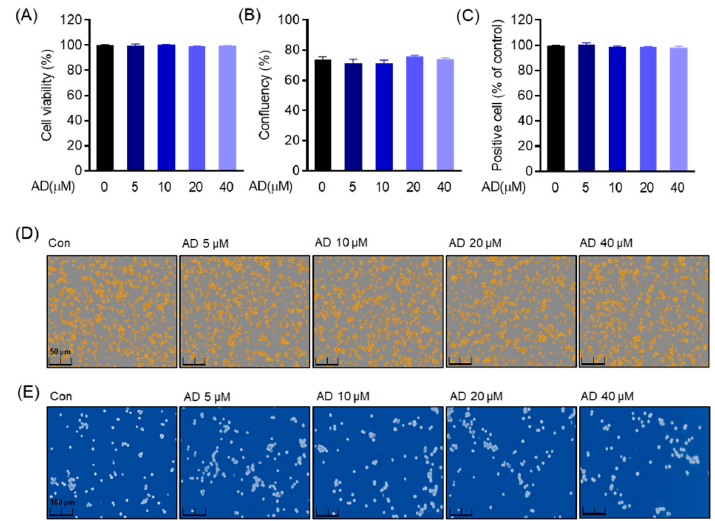
Figure 2. Cell viability and confluency. Cytotoxic effect of AD at the indicated concentration after treating for 5 days at the density of 1 × 10 3 cells/well in the 96-well plate. ( A ) Measurement of cell viability by MTT. ( B , D ) Cell confluency measurement by Incucyte ® Live Cell analysis systems. ( C , E ) Positive cell measurement through trypan blue staining analysis.